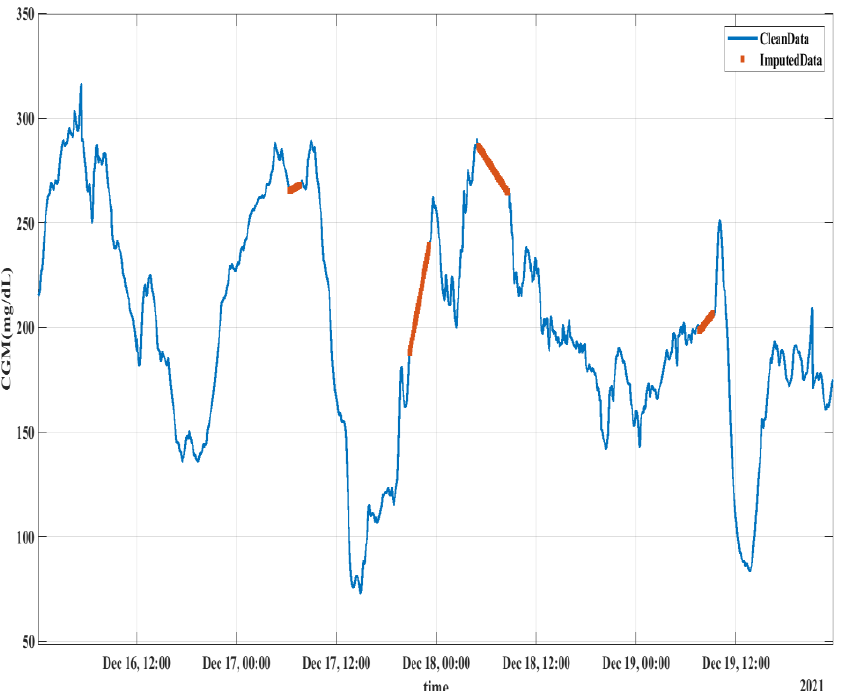
Figure 3. Missing CGM data imputation using linear interpolation. The orange lines represent the interpolated sample data, which were missing in the original dataset.